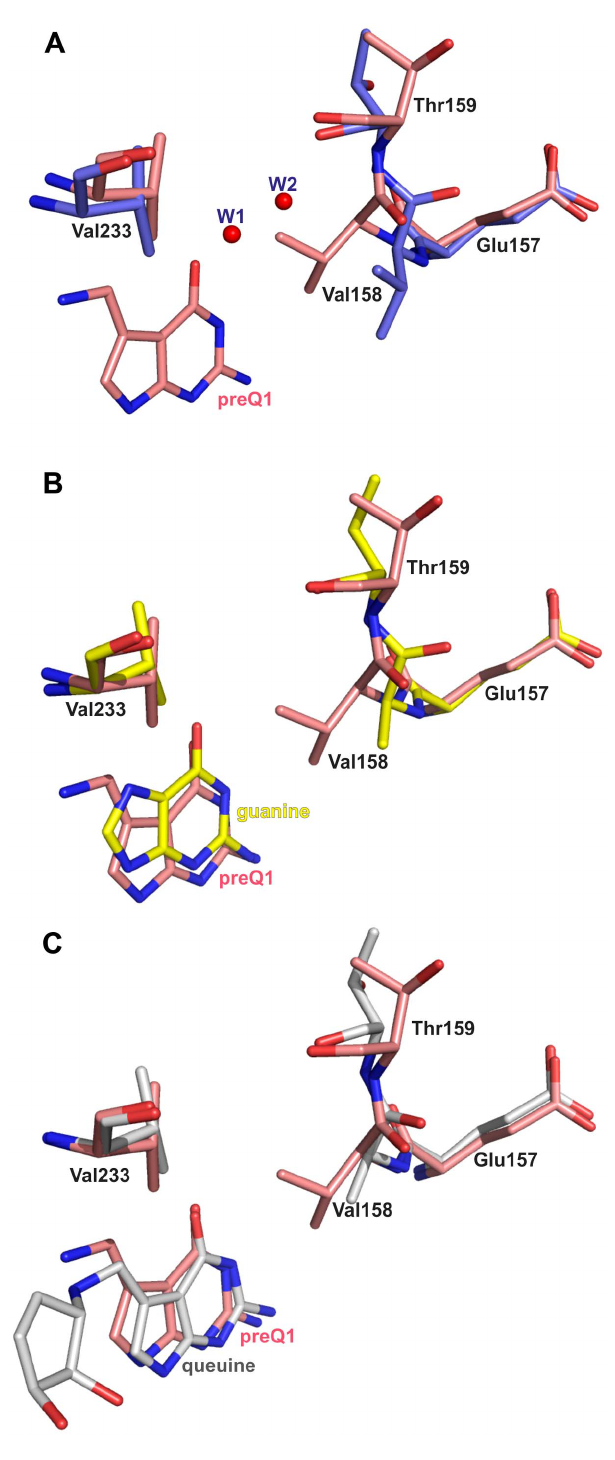
Figure 9. Superimposition of preQ 1 -bound Tgt(Cys158Val) with its apo-, its guanine- and its queuine-bound form. Carbon atoms of the Tgt(Cys158Val) ? preQ 1 complex are coloured pink in all sub-figures. (A) Superimposition (based on c a ) of preQ 1 -bound Tgt(Cys158Val) and apo-Tgt(Cys158Val). Carbon atoms of apo- Tgt(Cys158Val) are coloured blue. Binding of preQ 1 to Tgt(Cys158Val) provokes a shift of Val158 towards the ligand leading to the displacement of two water molecules (W1 and W2; shown as red spheres) which are present within this region in apo-Tgt(Cys158Val) and absent in the complex structure. In addition, the side chain of